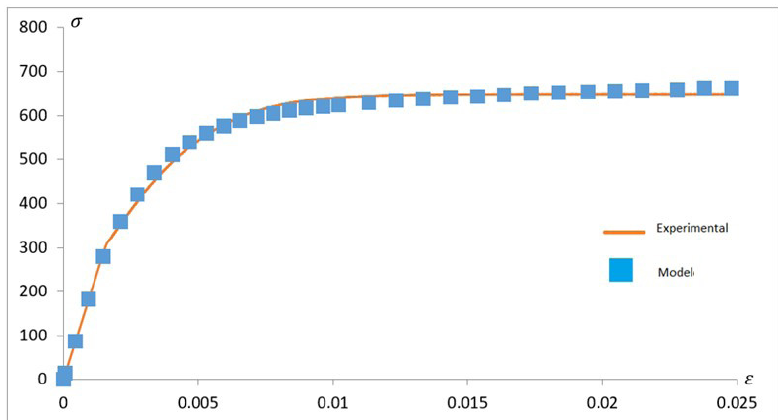
Figure 12. Comparative stress curve (MPa) - strain (mm / mm) - ε_2=